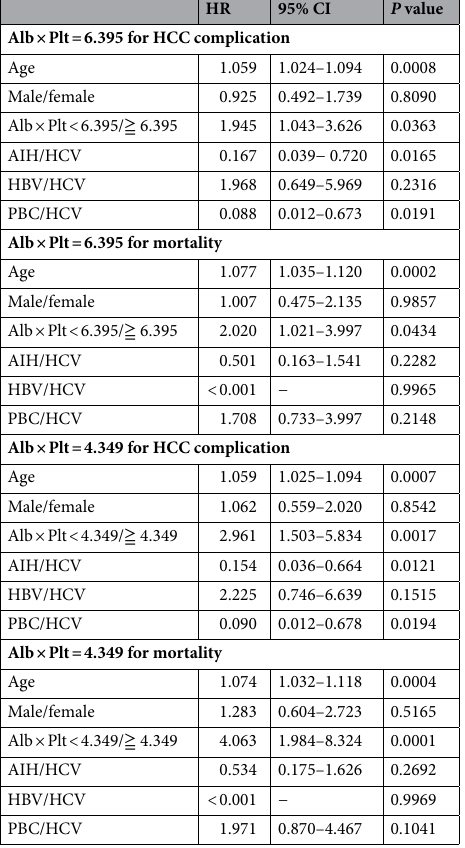
Table 2. Prediction of HCC prevalence and mortality by Albumin platelet product in a training cohort. AIH autoimmune hepatitis, Alb albumin, Plt platelet, HBV hepatitis B virus, HCC Hepatocellular carcinoma,